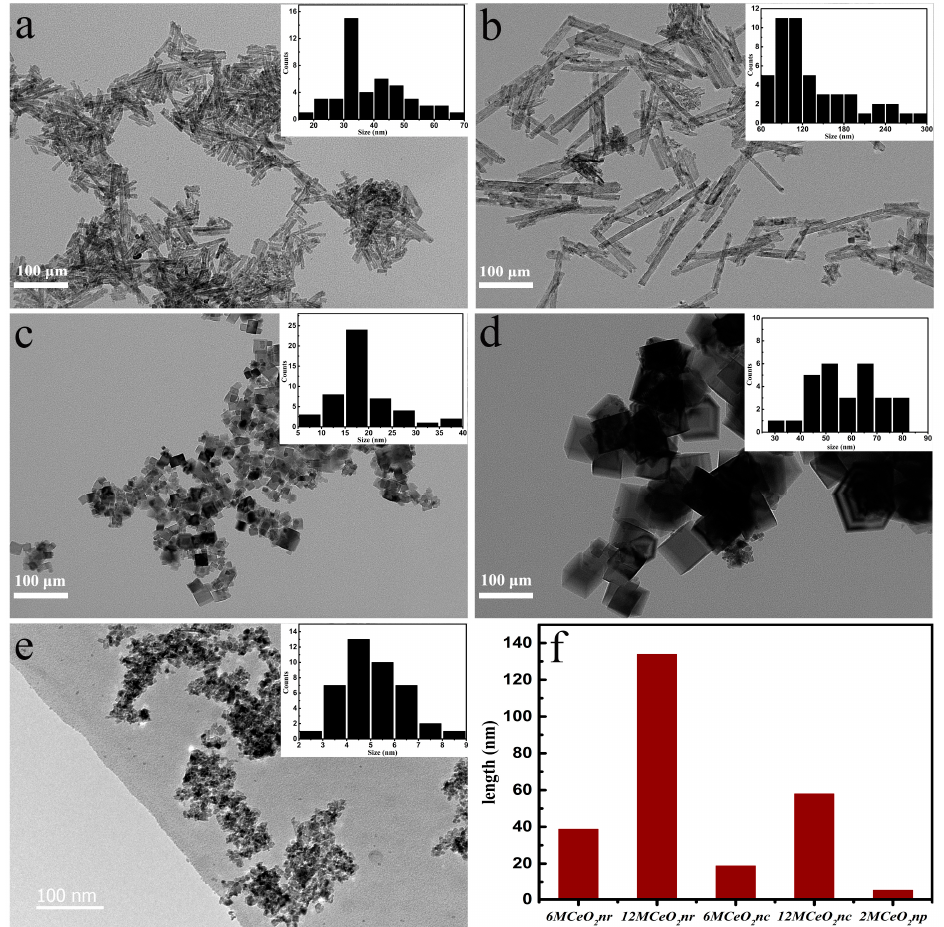
Figure 2. TEM images of CeO 2 nanomaterials ( a ) 6MCeO 2 nr, ( b ) 12MCeO 2 nr, ( c ) 6MCeO 2 nc, ( d ) 12MCeO 2 nc, and ( e ) 2MCeO 2 np. The scalebar is 100 nm and the insets show the length distribution histograms (28 nanoparticles were measured for each histogram by Nano Measurer software v1.2.5); ( f ) mean length distribution diagram of CeO 2 nr, CeO 2 nc, and CeO 2 np calculated from the length distribution histograms.